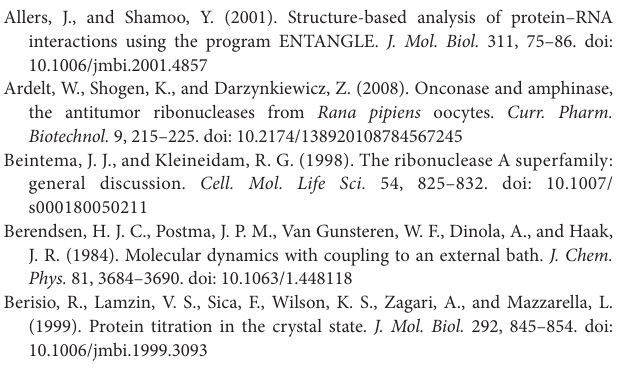
as follows: red box, white character for strict identity; red character for similarity within a group; and character with blue frame for similarity across groups. SUPPLEMENTARY FIGURE 9 | Sequence alignment of representative sequences of reptilian RNases. Protein regions identified to participate in B2 site are highlighted in yellow (L4, spanning from b 2 to b 3, end of β 6 and one of the two catalytic histidines together with a close by residue at β 7). Main conserved key residues are: Asn68 and Asp116/Arg117. TT indicates the presence of a β -turn . Dots label every 10 residues of the reference protein used (Cm-RNase 1). The disulphide bonds are labelled with green numbers. The alignment was performed using Clustal Omega (Sievers and Higgins, 2018), and the picture was drawn using ESPript (Robert and Gouet, 2014). Labels are as follows: red box, white character for strict identity; red character for similarity within a group; and character with blue frame for similarity across groups. SUPPLEMENTARY FIGURE 10 | Sequence alignment of representative sequences of bird RNases. Protein regions identified to participate in B2 site are highlighted in yellow (L4, spanning from b 2 to b 3, end of β 6 and one of the two catalytic histidines together with a close by residue at β 7). Main conserved key residues are: Asn65, Arg66 and Trp105. TT indicates the presence of a β -turn . Dots label every 10 residues of the reference protein used (Gg-RNase 1). The disulphide bonds are labelled with green numbers. The alignment was performed using Clustal Omega (Sievers and Higgins, 2018), and the picture was drawn using ESPript (Robert and Gouet, 2014). Labels are as follows: red box, white character for strict identity; red character for similarity within a group; and character with blue frame for similarity across groups. SUPPLEMENTARY FIGURE 11 | Sequence alignment of representative sequences of mammalian RNases. Protein regions identified to participate in B2 site are highlighted in yellow (L4, spanning from b 2 to b 3, end of β 6 and one of the two catalytic histidines together with a close by residue at β 7). Main conserved key residues are: Asn67/Gln69/Asn71, Ala109, Glu111 and Arg122. TT indicates the presence of a β -turn . Dots label every 10 residues of the reference protein used (Bt-RNase 1). The disulphide bonds are labelled with green numbers. The alignment was performed using Clustal Omega (Sievers and Higgins, 2018), and the picture was drawn using ESPript (Robert and Gouet, 2014). Labels are as follows: red box, white character for strict identity; red character for similarity within a group; and character with blue frame for similarity across groups. SUPPLEMENTARY TABLE 1 | Phylogenetic classification and abbreviations used for the analysed species. SUPPLEMENTARY TABLE 2 | Main key residues identified by molecular dynamic simulations of the studied RNase complexes with UpA, UpG and UpI. Equivalent residues by structural superposition are indicated. Cationic residues are indicated in blue, anionic residues in red and polar residues in black. Histidine residues involved in stacking interactions with the purine base are coloured in orange. Only specific interactions with purine atoms are included. Specific interaction to purine atoms are illustrated in Figure 5